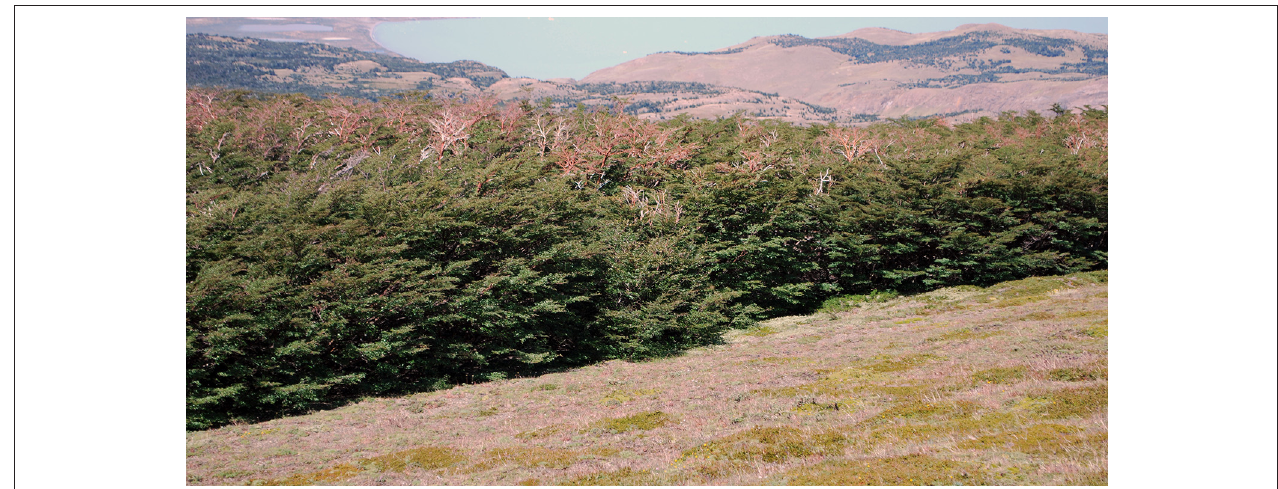
FIGURE 1 | Abrupt treeline in the El Chaltén. Picture taken by Ricardo Villalba in the 2016–2017